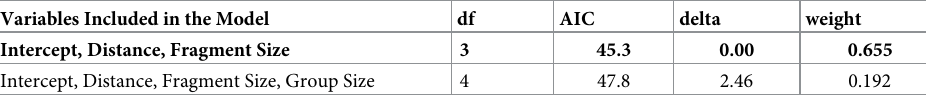
Table 1. Model selection